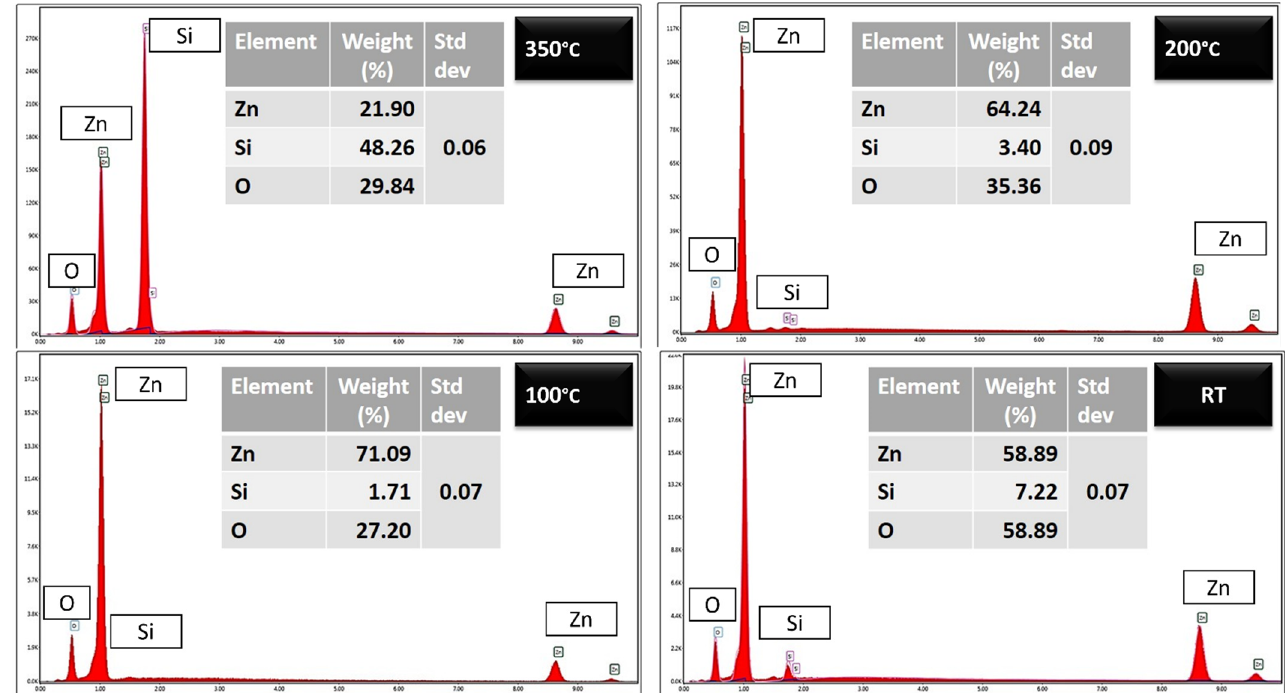
Figure 4. EDS spectra of deposited ZnO thin films with corresponding relative elemental composition estimated from the spectra.